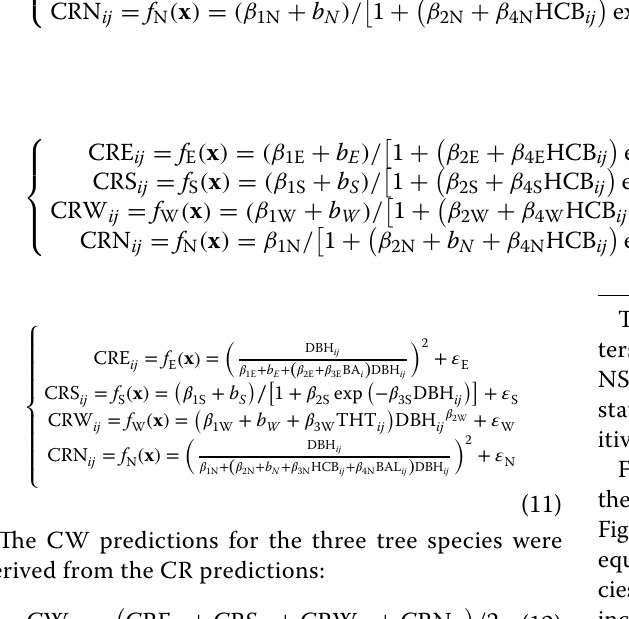
Table 4 Fixed parameter estimates of NSURMEM systems for larch, birch, and poplar